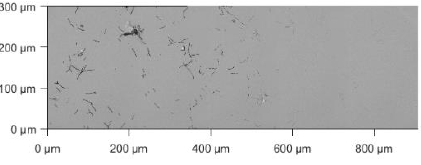
Fig. 4. Comparison between unetched and etched region on a N-BK7 surface.